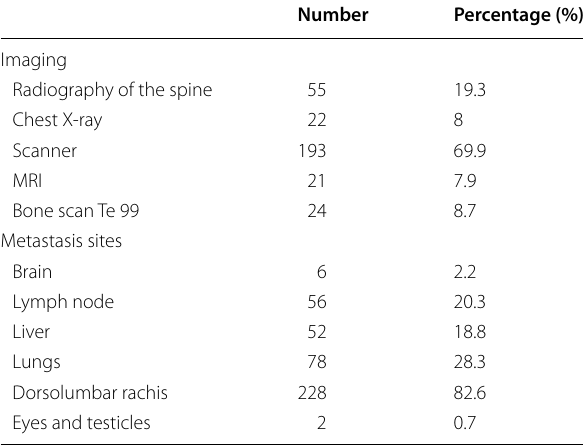
Table 3 The characteristics of the extension balance sheet